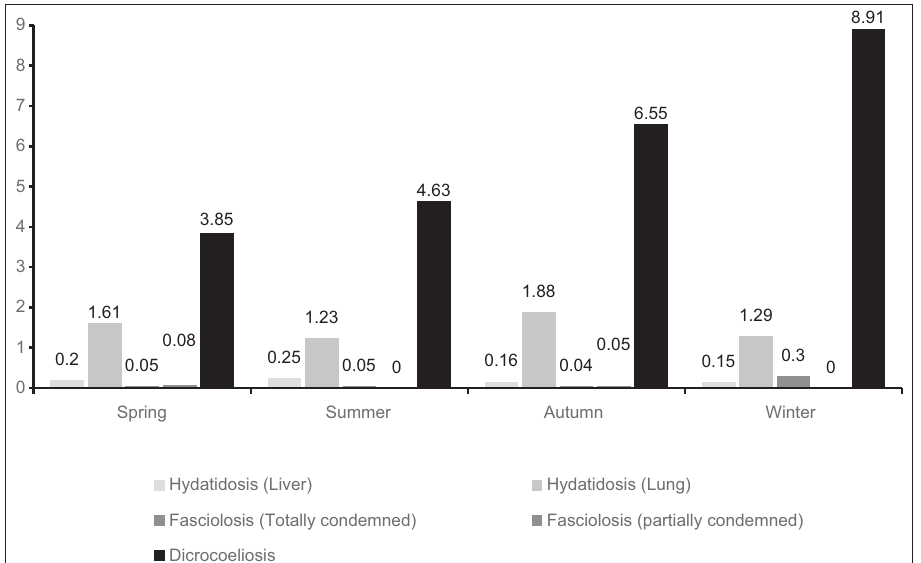
Figure-1: Seasonal pattern of prevalence (%) of hydatidosis (liver), hydatidosis (lung), Fasciolosis, and Dicrocoeliosis in slaughtered animals at Neyshabour abattoir during March 2016–March